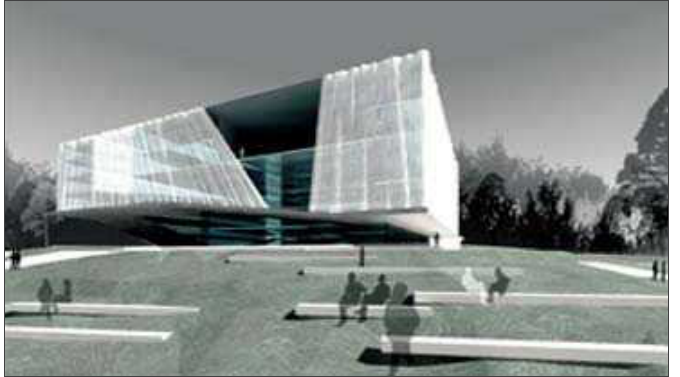
Fig. 11. entry to architectural competition for the public building on tauras hill (authors: Uab “Vilniaus architektūros studija”. archs. k. Pempė, a. Pliučas, G. Gečaitė, L. Jančytė, N. baran, J. Dagelis,